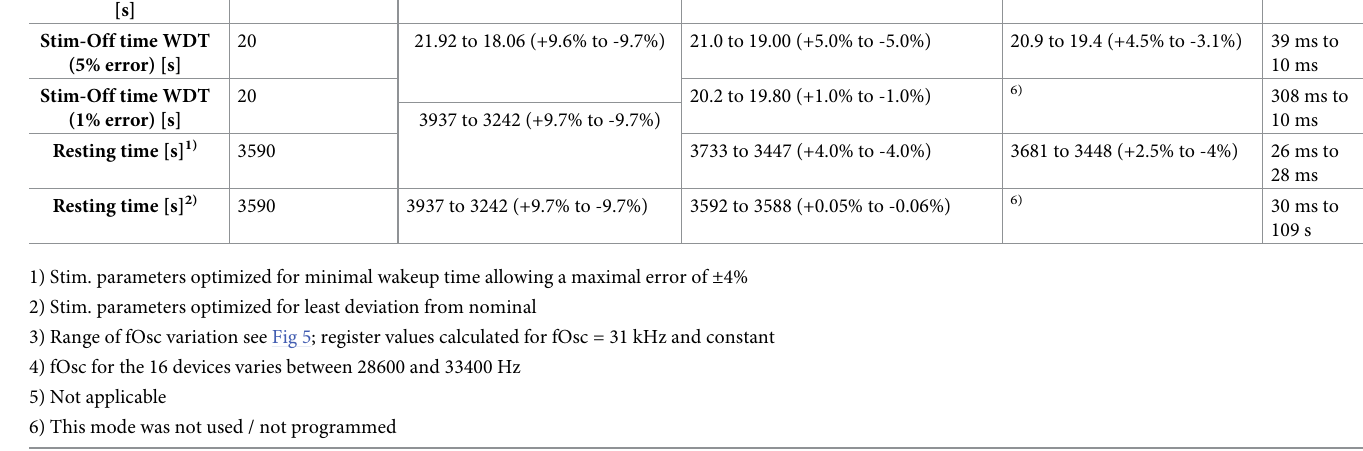
Table 2. Stimulation parameter ranges and deviation from the nominal value in% due to different oscillator frequencies. Nominal stim. Calculated stim. parameters due parameter to f Osc variation 3)